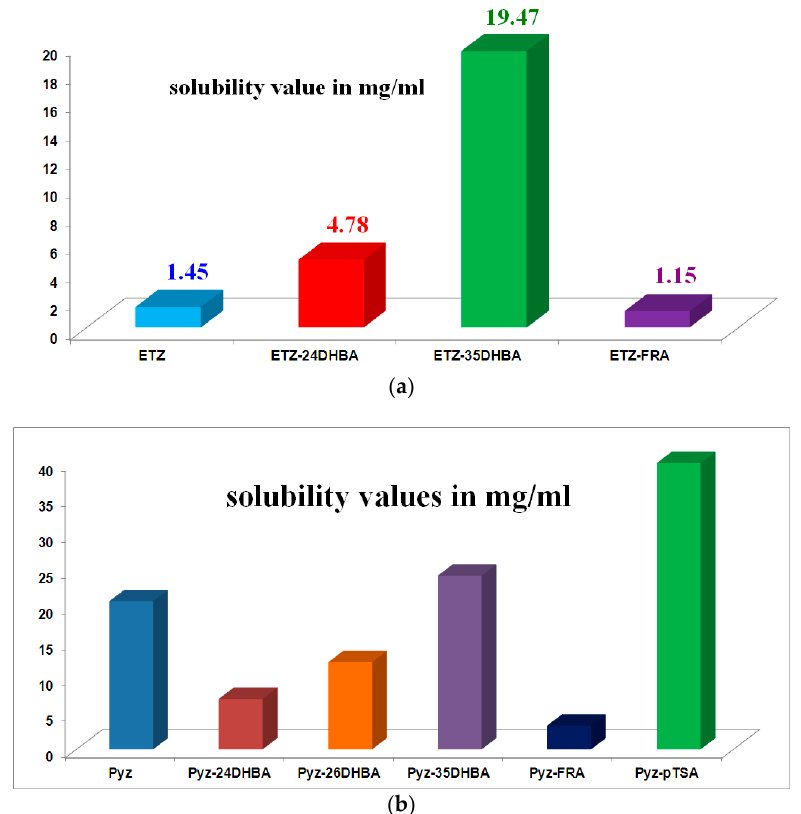
Figure 47. Bar diagram showing solubility profile of ( a ) ethenzamide cocrystals and ( b ) Pyz binary complexes. Ferulic acid is designated as FRA. Adapted with permission from CrystEngComm , 2017, 19, 826–833. Copyright 2017, The Royal Society of Chemistry.